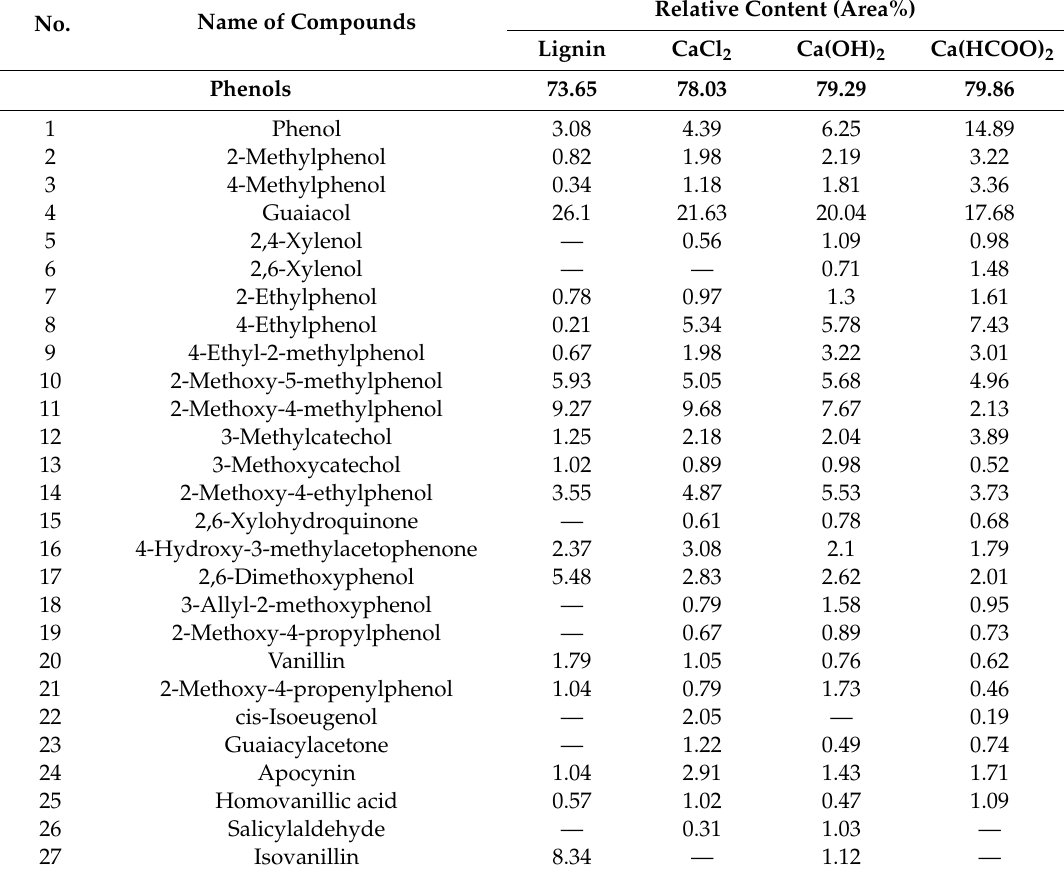
Table 1. The major compositions of bio-oil from lignin pyrolysis with and without calcium salt additives. No. Name of